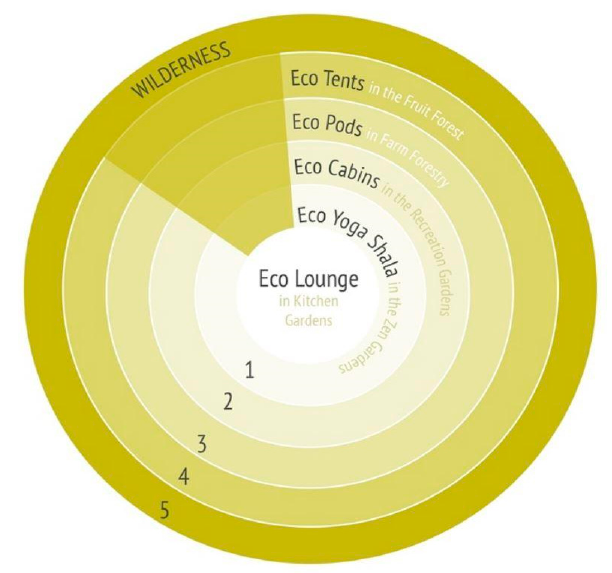
Figure 5. Permaculture design method of zones classifies with the lowest number the most frequently used areas, while the highest number the least used areas (Source: compiled by the author).